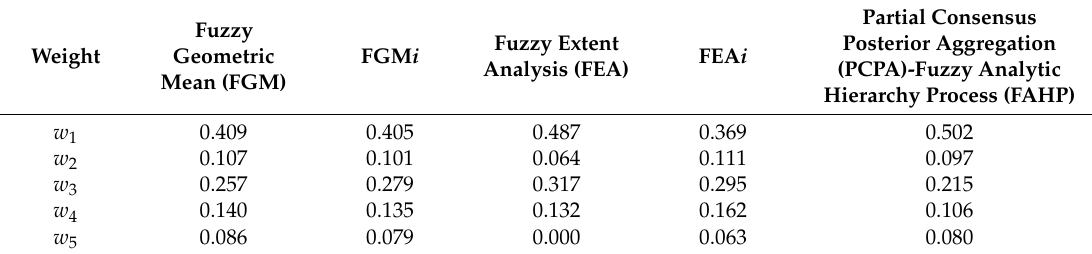
Table 5. The weights estimated using various